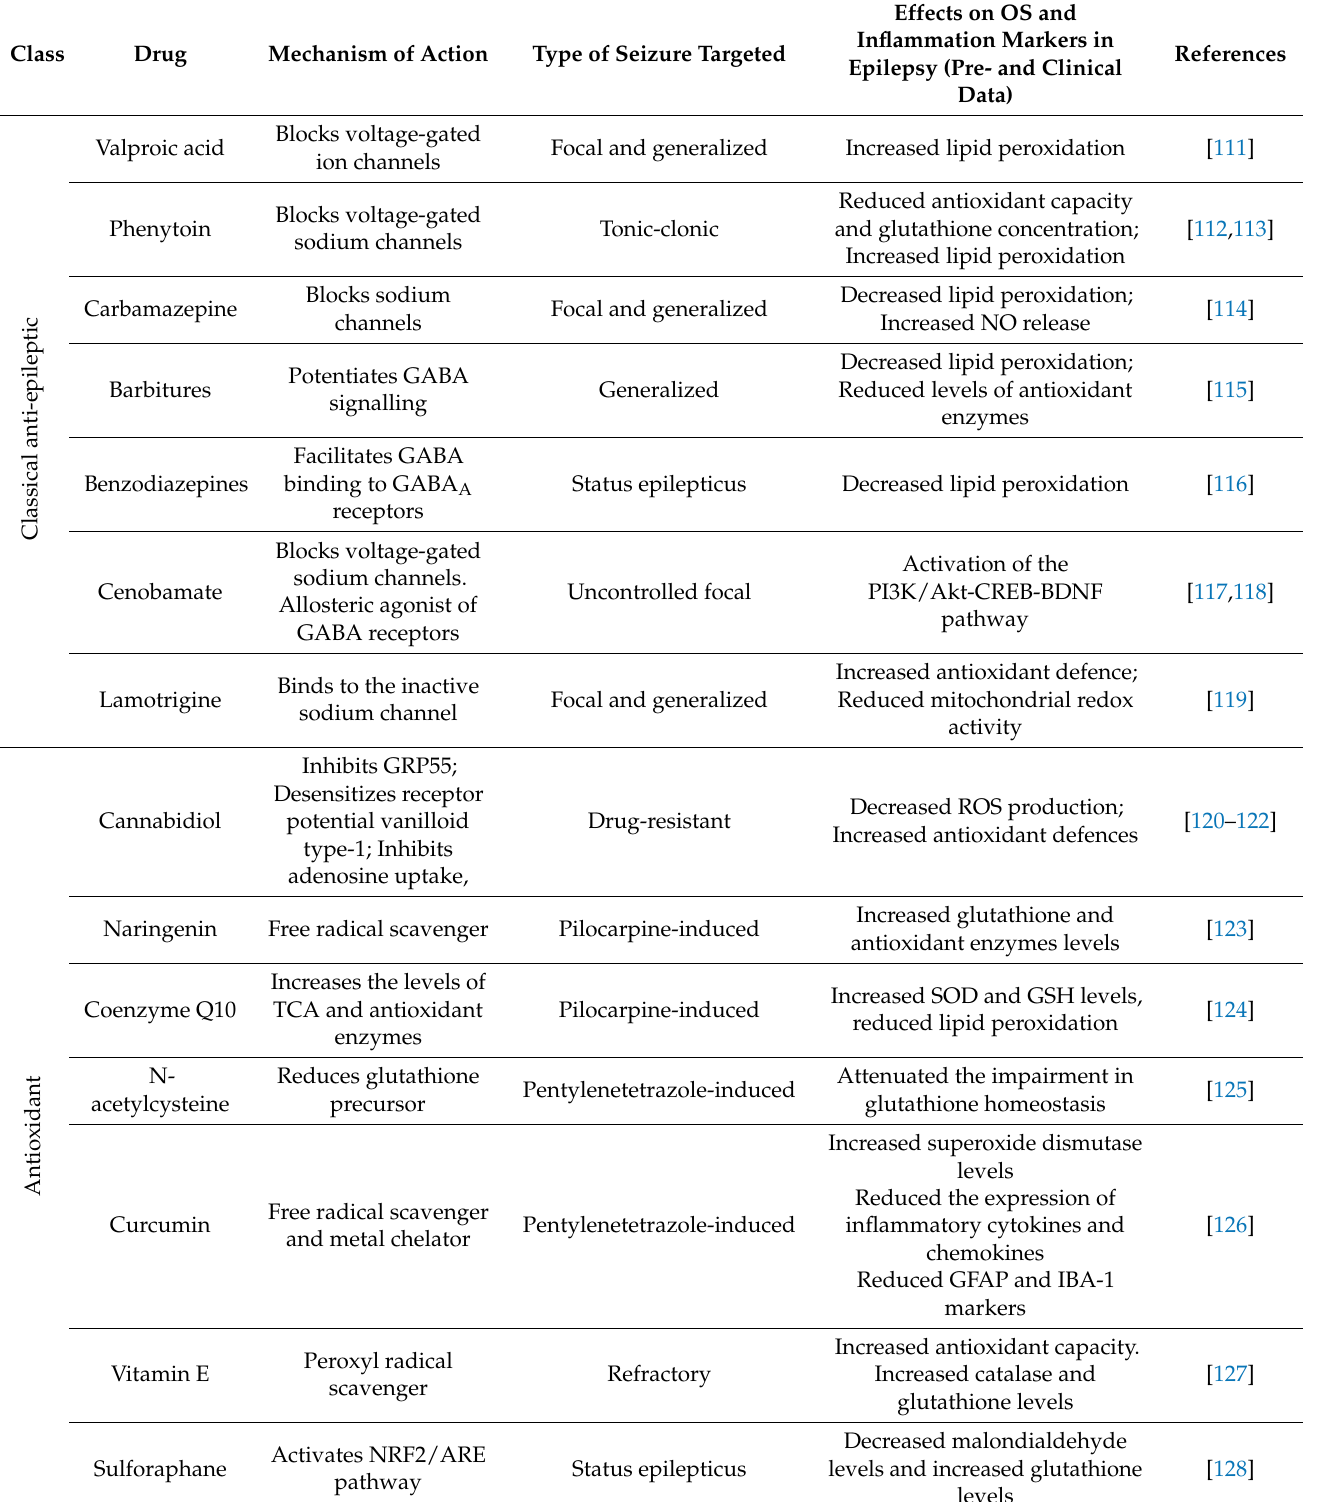
Table 1. Pharmacological effects of classical AEDs, antioxidants and anti-inflammatory compounds on epilepsy, OS and inflammatory